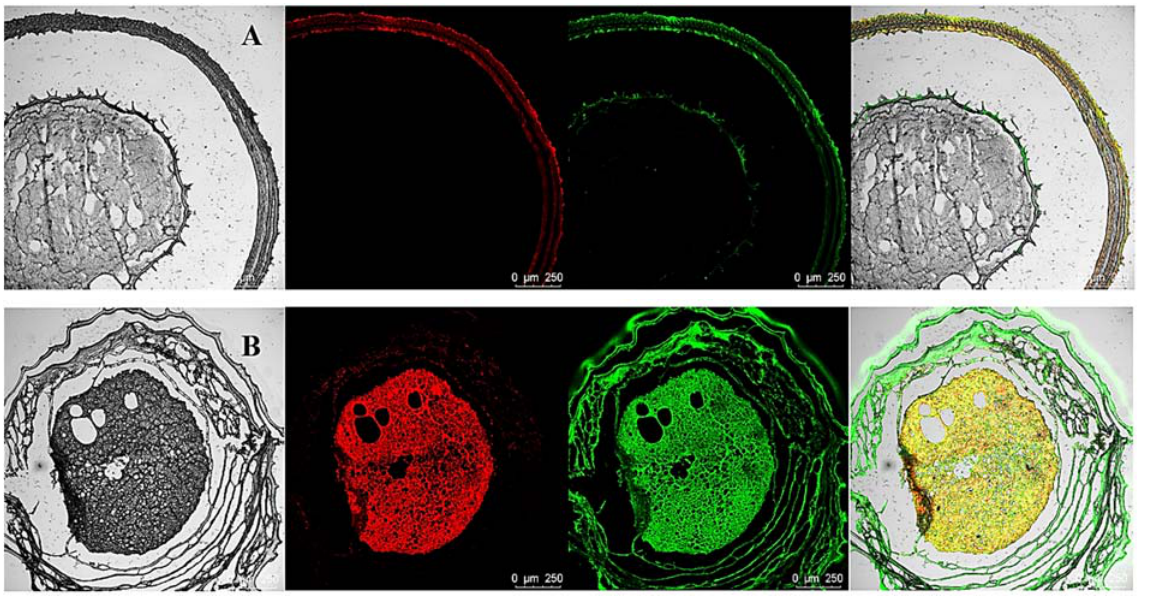
Figure 2. Confocal microscopy images of three-layer BC-loaded-gel microspheres (L 3 -BC) with embedding at different locations. Confocal microscopy images of 2.5% SA three-layer BC-loaded-gel microspheres ( A ). Confocal microscopy images of 1.5% SA three-layer BC-loaded-gel microspheres ( B ). The images were obtained by conventional optical microscopy and confocal fluorescence microscopy after sectioning the samples using a microtome. Table 1. Springiness and hardness of gel